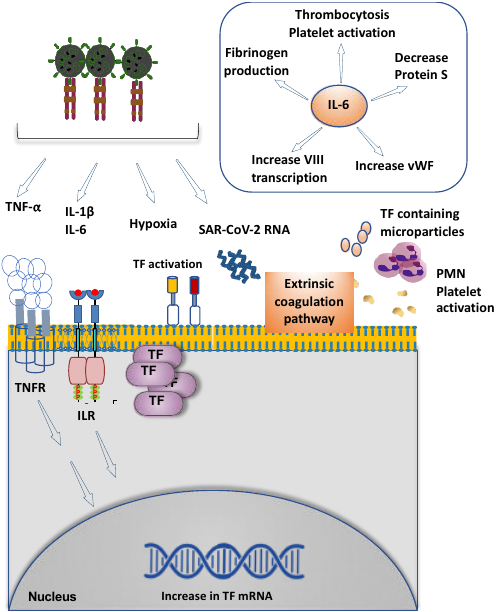
Fig.1MechanismsofphysiologicalandoncogenicRTKactivation.aSchematicrepresentationofRTKactivationinnormalphysiology.RTKsare activatedthroughformationofinter-moleculardimerizationinthepresenceofligands,resultinginkinaseactivationandphosphorylationofthe Figure 2. The prothrombotic milieu in COVID-19 patients is generated by several factors of which receptorC-terminaltail.bSchematicrepresentationofpotentialgain-of-functionmutationsinthevarioussubdomainsofanRTK.Themutations leadtoconstitutiveactivationoftheRTK,typicallyintheabsenceofligand.cOverexpressionofRTKs – oftenasaresultofgenomicamplification stimulation of extrinsic coagulation assumes a central stage. Damage to the endothelial cells activates oftheRTKgene-leadstoincreasedlocalconcentrationofreceptors